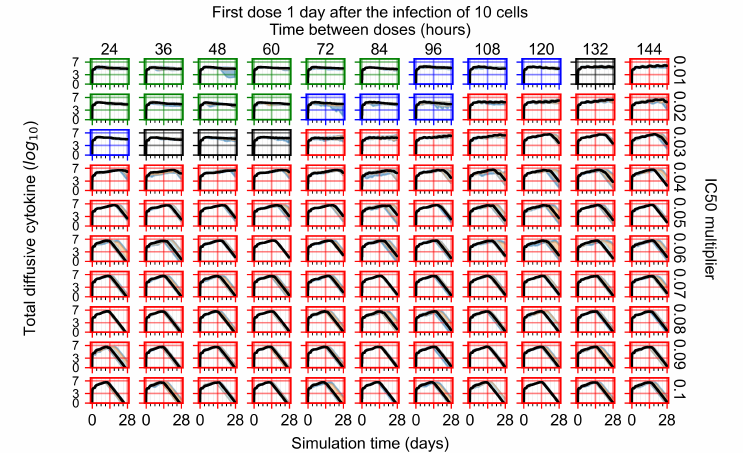
Figure A54. Diffusive cytokine amount, Y axis in log scale, and exponent values as tick marks.